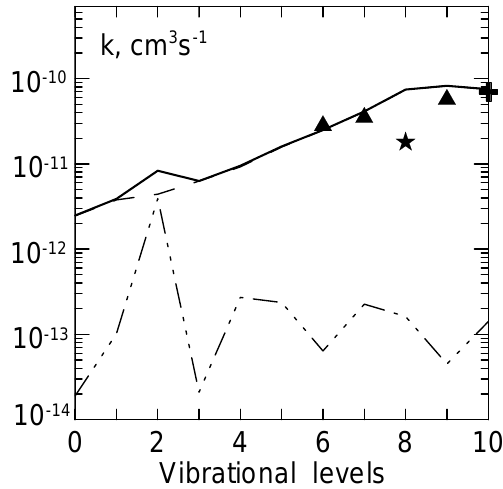
Fig. 3. The calculated quenching rate coefficients of O 2 (A 0 3 1 u , v =0-11)+O 2 – solid line. Dashed line and dash and three dotted line are the contributions of intramolecular and intermolecular electron energy transfer processes,